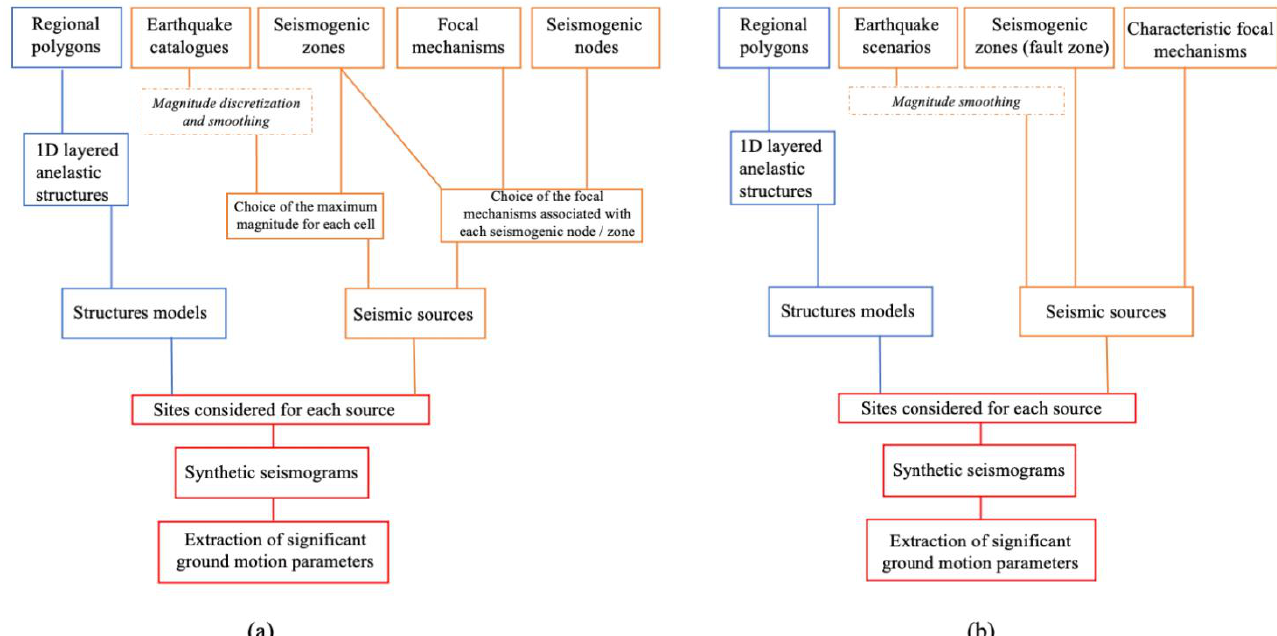
Figure 3. NDSHA computation scheme: ( a ) standard procedures; ( b ) adjust procedures. 4.